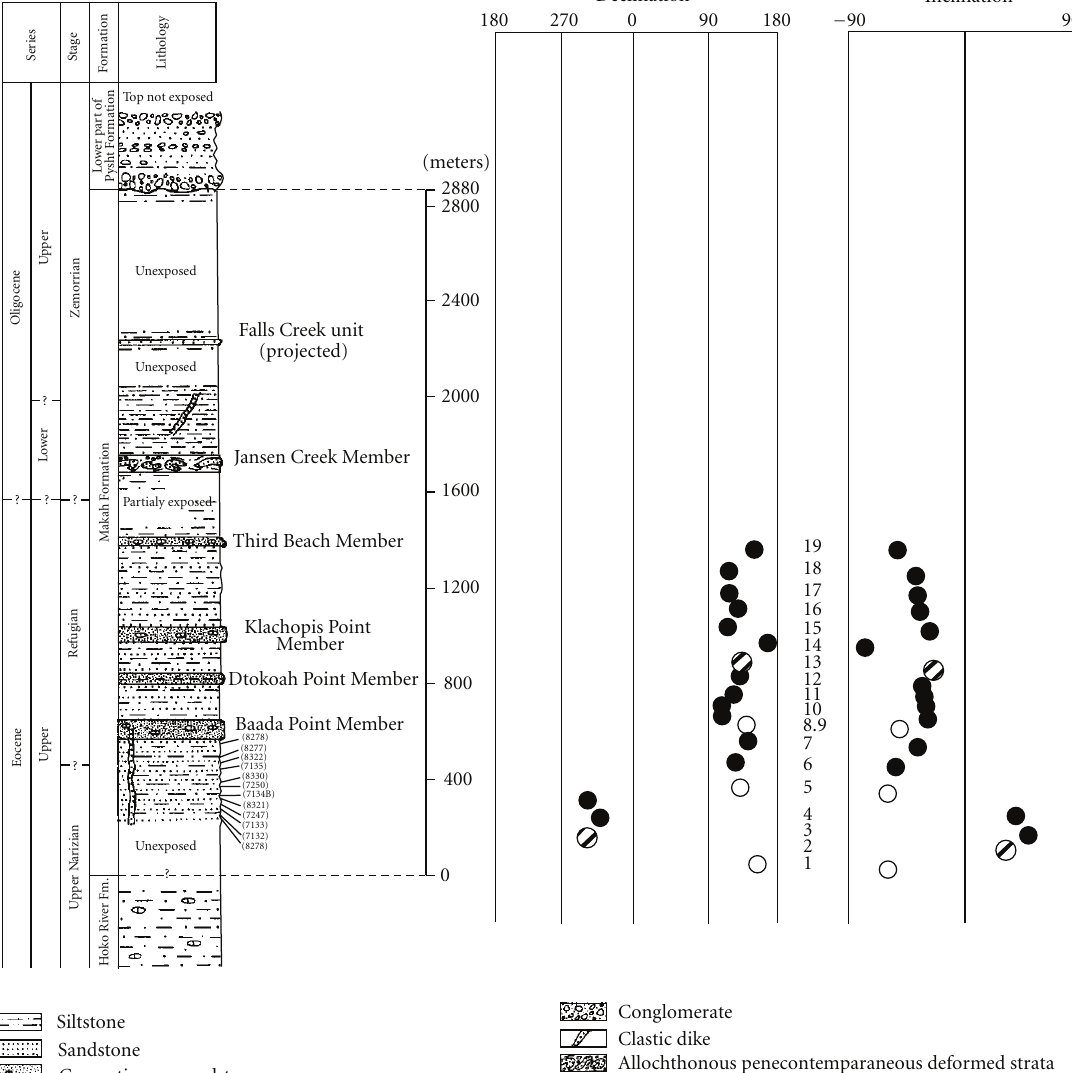
are east and up (clearly not a modern normal